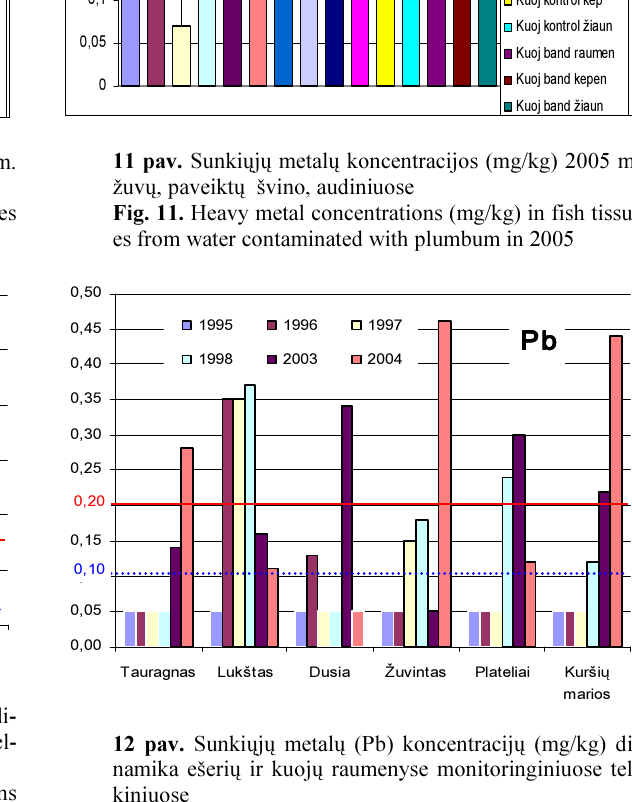
viršijo DLK: 1995 m. – Lukšte, 1996 m. – Plateliuose, 1997 m. – Dusioje (14